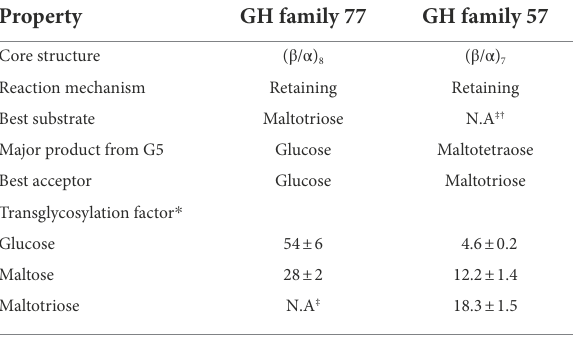
TABLE 3 Comparison of biological function between two glucanotransferase GH family.